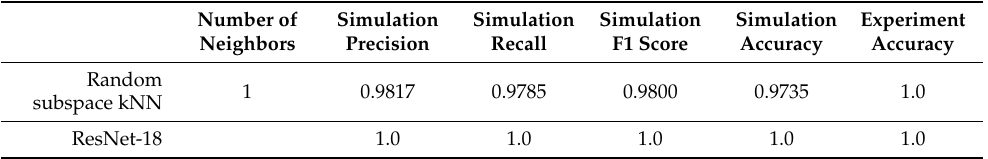
Table 2. The results (precision, recall, F1 score and accuracy) of simulation and experimental data of the final model using random subspace kNN and